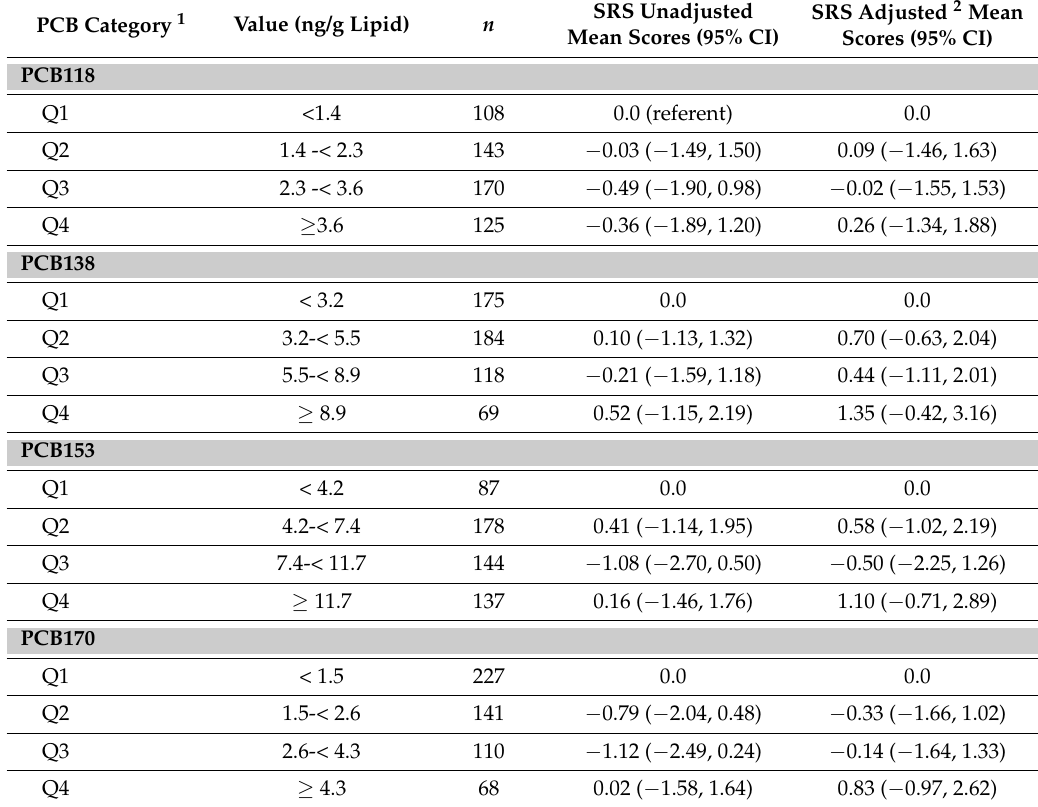
Table 1. Mother PCB levels (quartiles) in relation to mean child SRS score in MIREC study participants, Canada, 2008–2011 using Bayesian linear regression ( n =